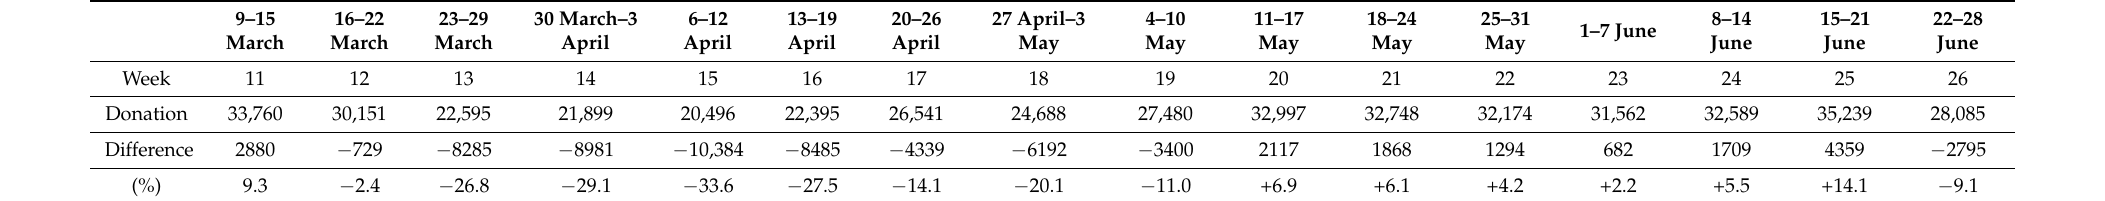
Table 1. Evolution of donations in the Spanish State *.